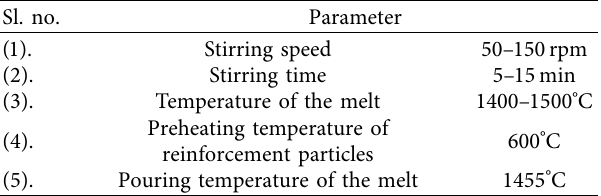
Figure 2: Procedural steps for sand mold casting. Table 3: Process parameters of the